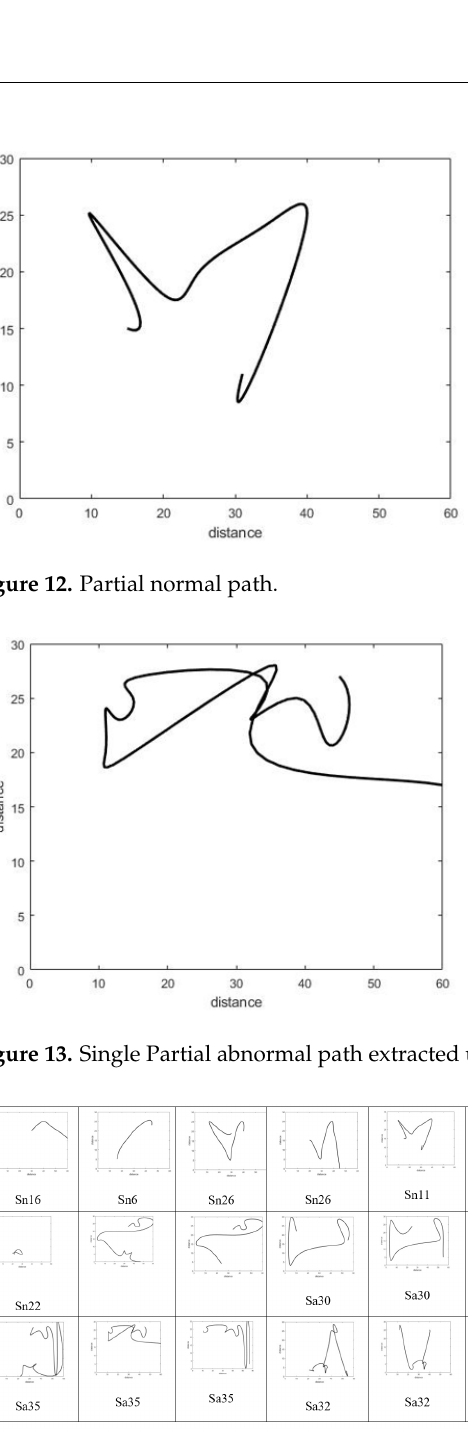
Figure 14. Multiple Partial abnormal paths for different scenarios extracted using the